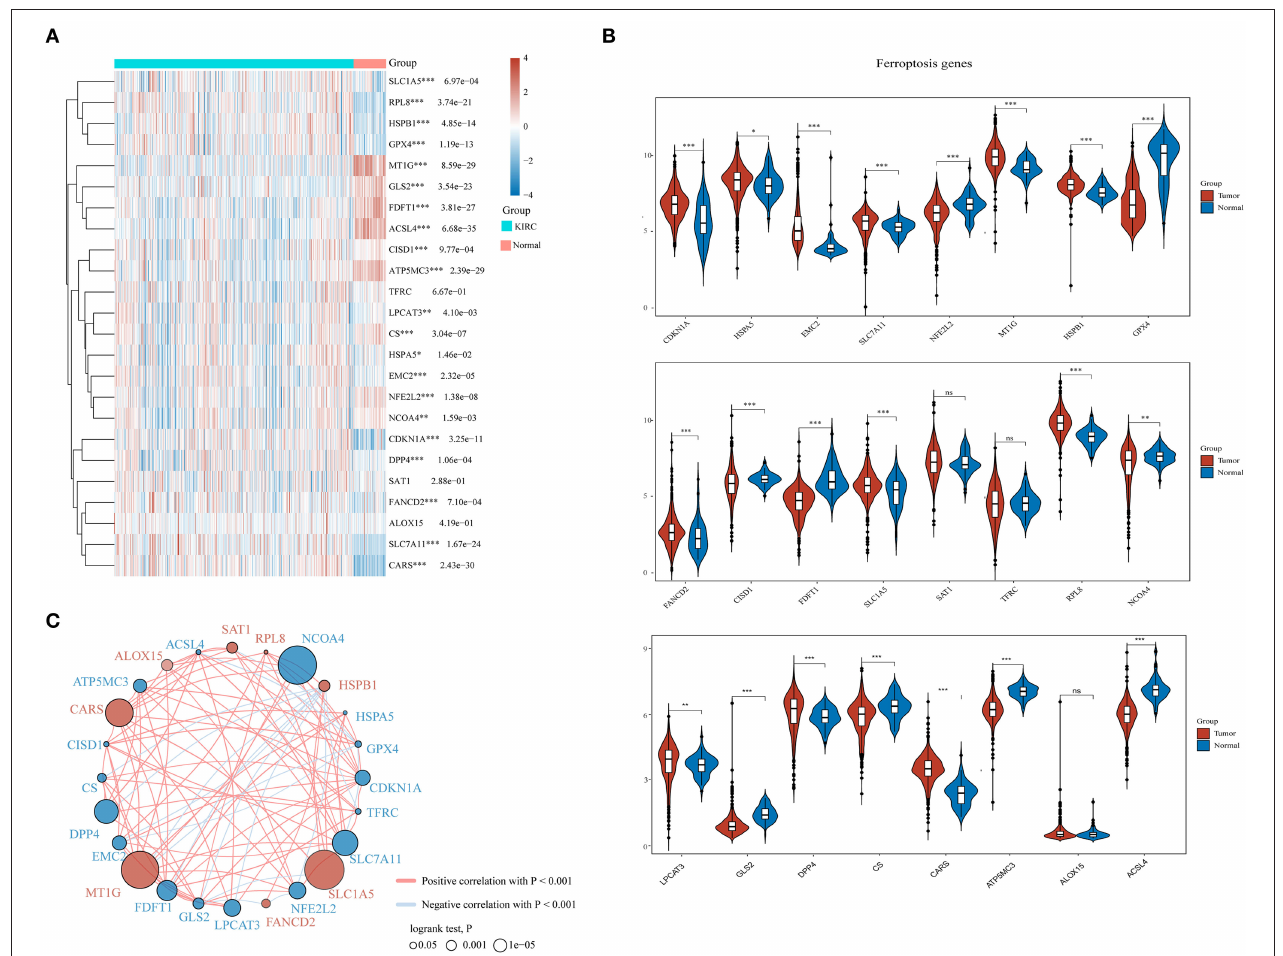
FIGURE 1 | The expression distribution, correlation, and prognostic values of ferroptosis regulators in clear cell renal cell carcinoma (ccRCC) patients. Heat map (A) and violin plots (B) of ferroptosis regulators in ccRCC compared to normal tissues. (C) Spearman correlation and prognostic values of ferroptosis regulators in ccRCC. The red and blue line respectively represents the positive and negative correlation. The red and blue dot represents bad and good prognosis, respectively. The larger the circle, the smaller the prognosis log rank p . * p < 0.05, ** p < 0.01, and *** p <